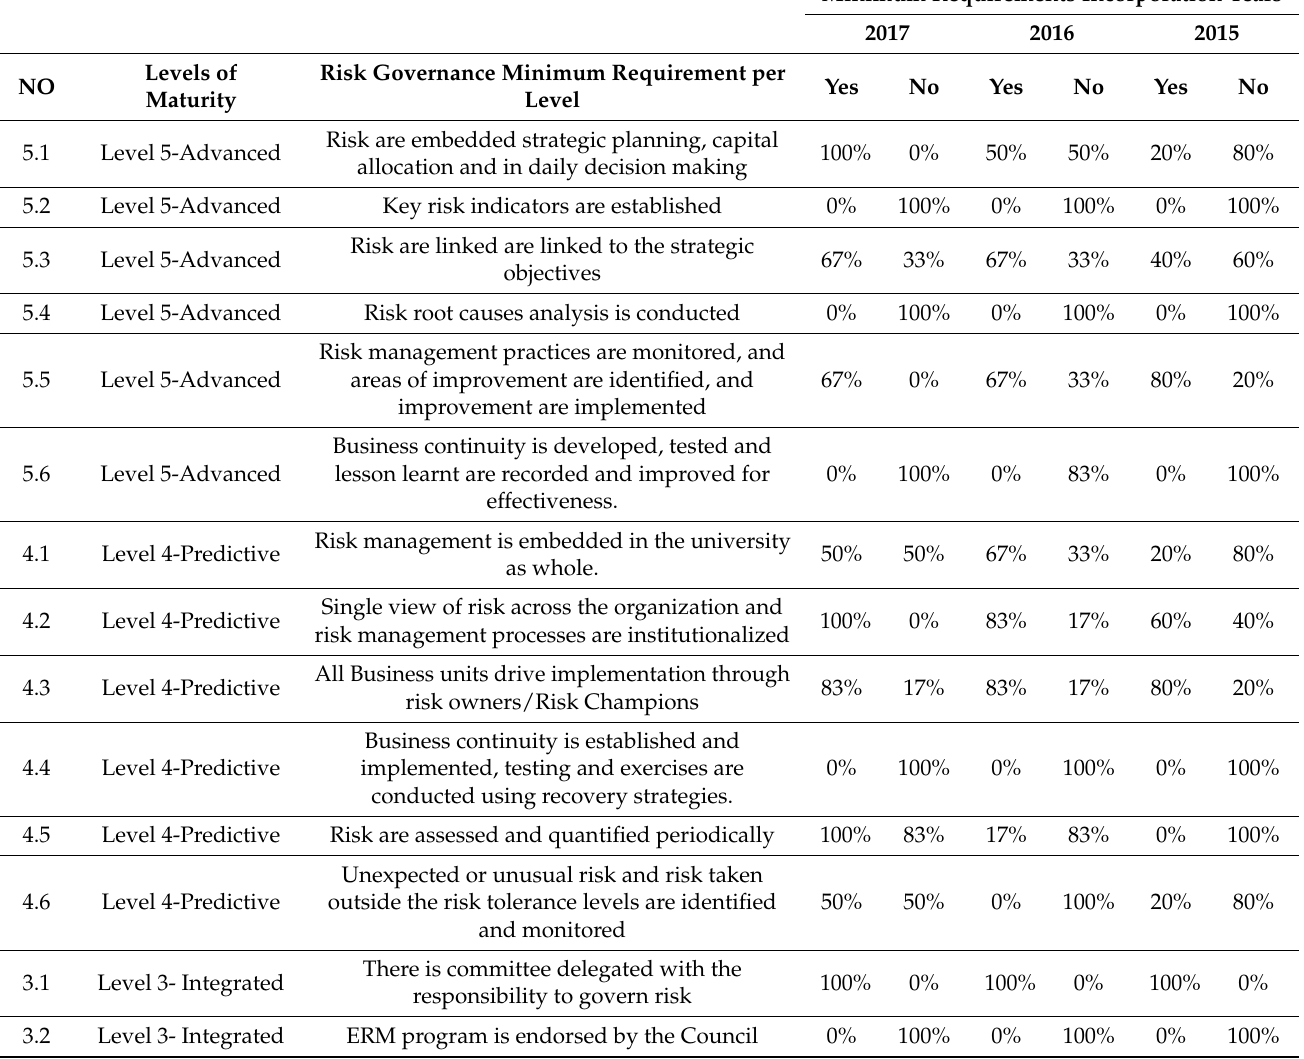
Table 4. Risk governance